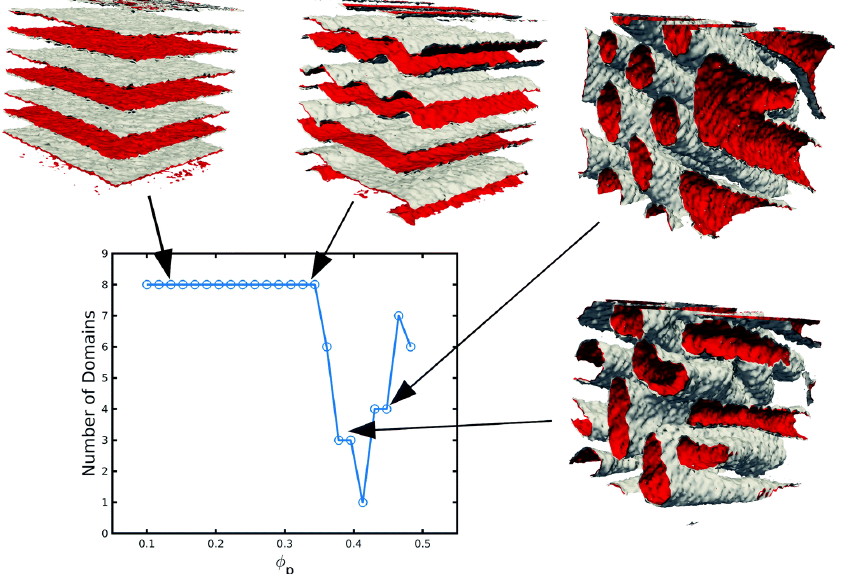
Figure 12. BCP transition from lamellar-forming to hexagonally ordered cylinders, tracked by the number of domains of a symmetric ( f 0 = 1/2) BCP as a function of the concentration of colloids φ p . Snapshots of the final state of some representative simulations are shown, where the colloids are not shown for clarity. Reprinted with permission from Ref. [182] 2019 Royal Society of